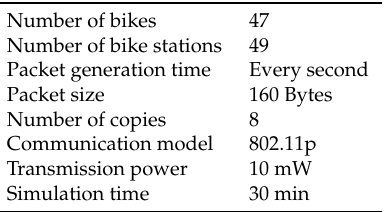
Table 2. Simulation